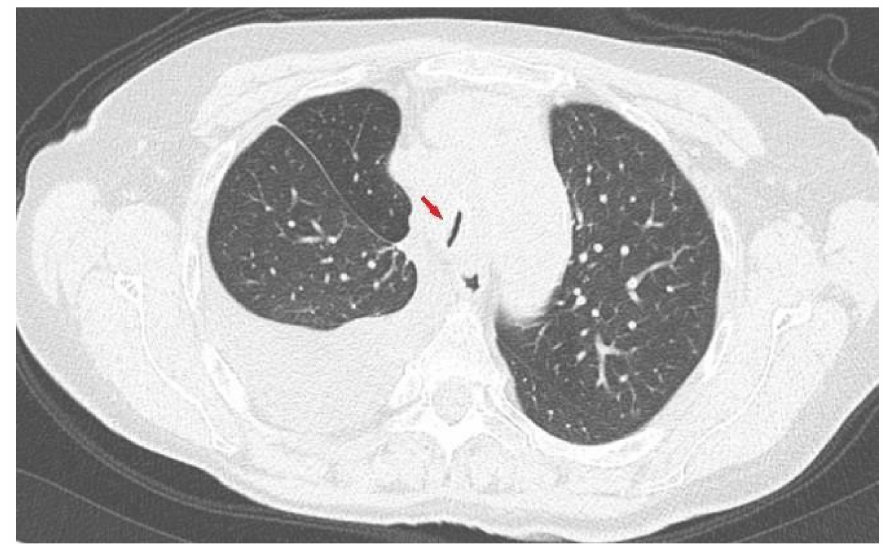
Figure 1. Chest computed tomography (CT) scan: axial lung image showing huge reduction (arrow) of the trachea lumen (2 mm) due to mediastinal pathological